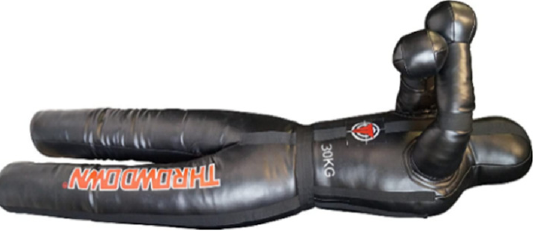
Figure 3. The human-sized dummy that was used during the test throws.